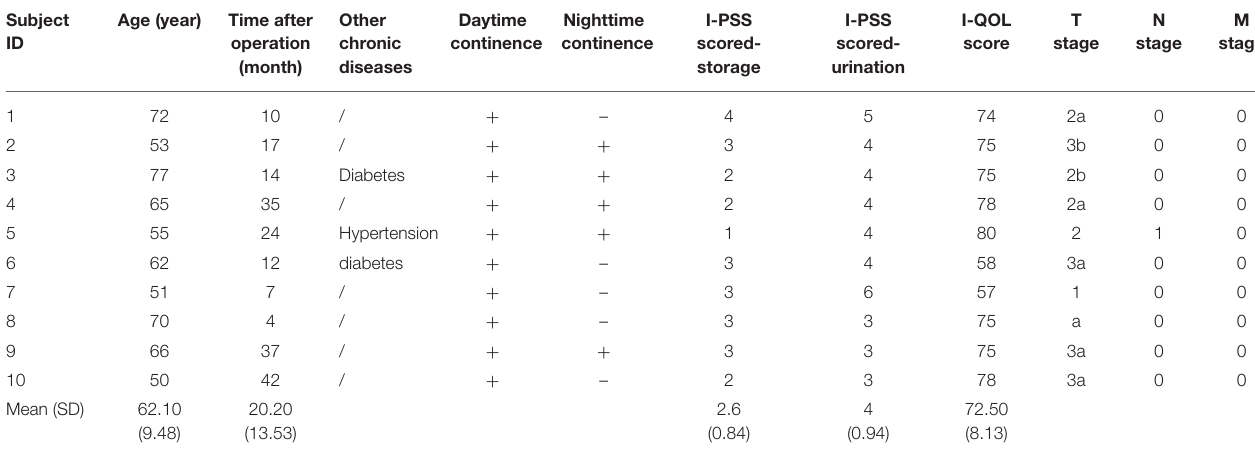
TABLE 1 | Baseline characteristics of subjects.